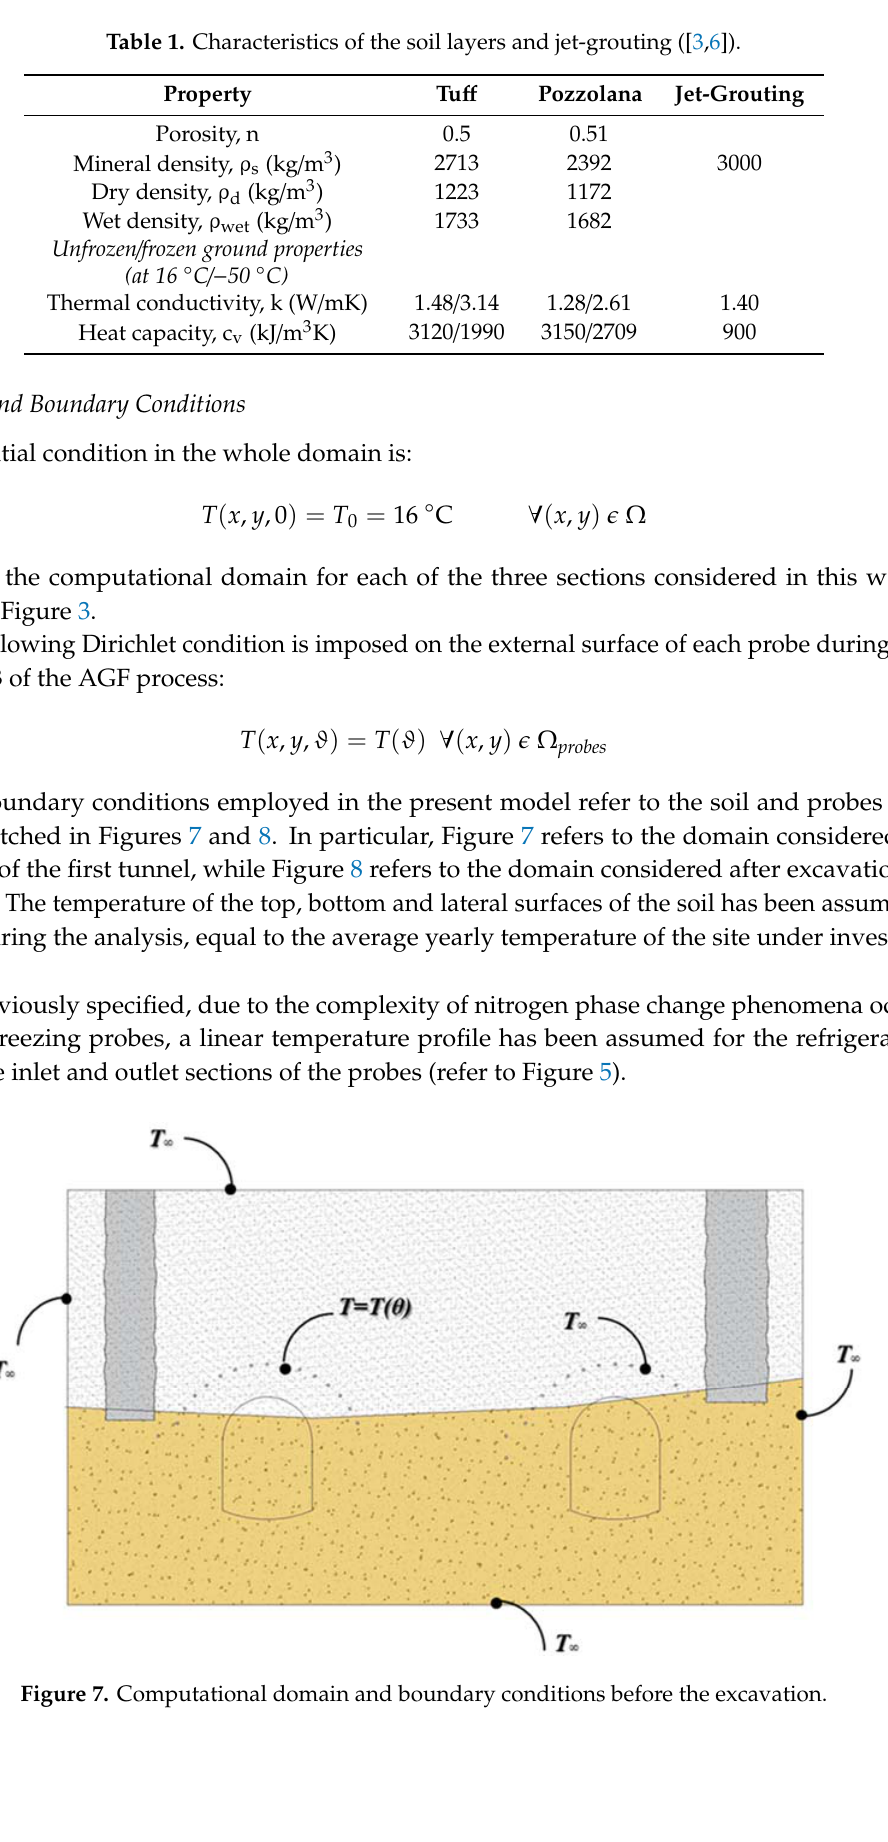
Figure 8. Computational domain and boundary conditions after the excavation of the odd tunnel. In order to simulate the excavation of the even tunnel, the same steps employed for that of the odd tunnel have been considered. During these phases, the excavated odd tunnel (left) has been reproduced by eliminating the corresponding domain of soil and applying a proper boundary condition (refer to Figure 8). This condition takes into account the presence of men, vehicles and air circulation in the excavated tunnel, and is represented by convective heat transfer on the walls of the odd tunnel: (cid:3398)𝑘∇(cid:3365)𝑇 ∙ 𝑛 (cid:3404) ℎ(cid:4666)𝑇 (cid:3398) 𝑇 (cid:2998) (cid:4667)